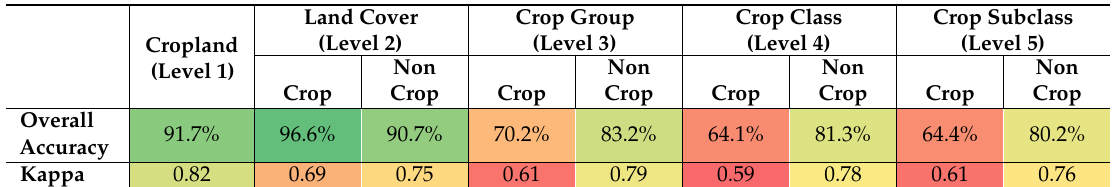
Table 4. The overall accuracy and Cohen’s Kappa obtained via the hierarchical approach for each level of the JECAM nomenclature. Colors along the green to red color gradient denote the accuracy of results from good to poor,